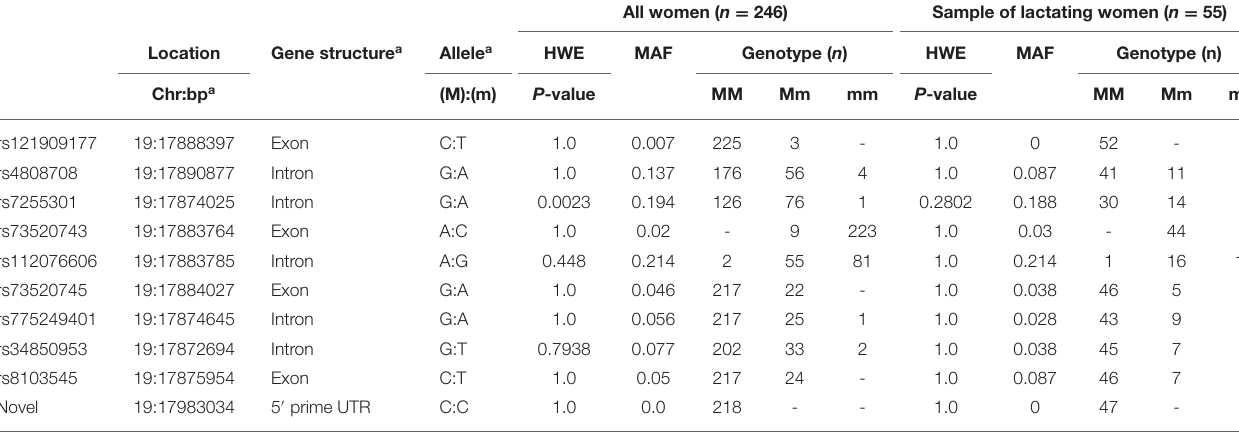
TABLE 2 | Molecular characteristics of SLC5A5 genetic variants among pregnant women ( n = 264) and the subset of lactating women ( n = 55). All women ( n = 246) Location Gene structure